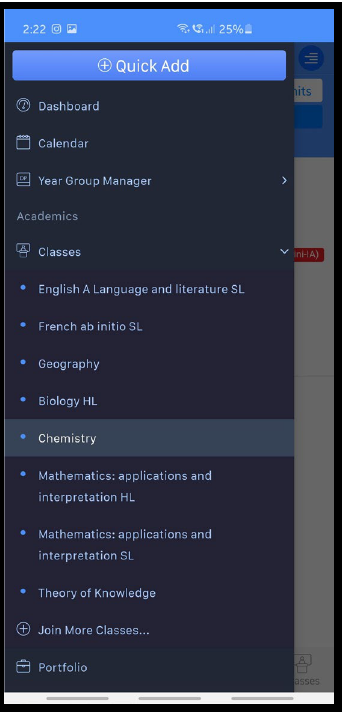
Figure 4 b. Student View of the Menu Panel